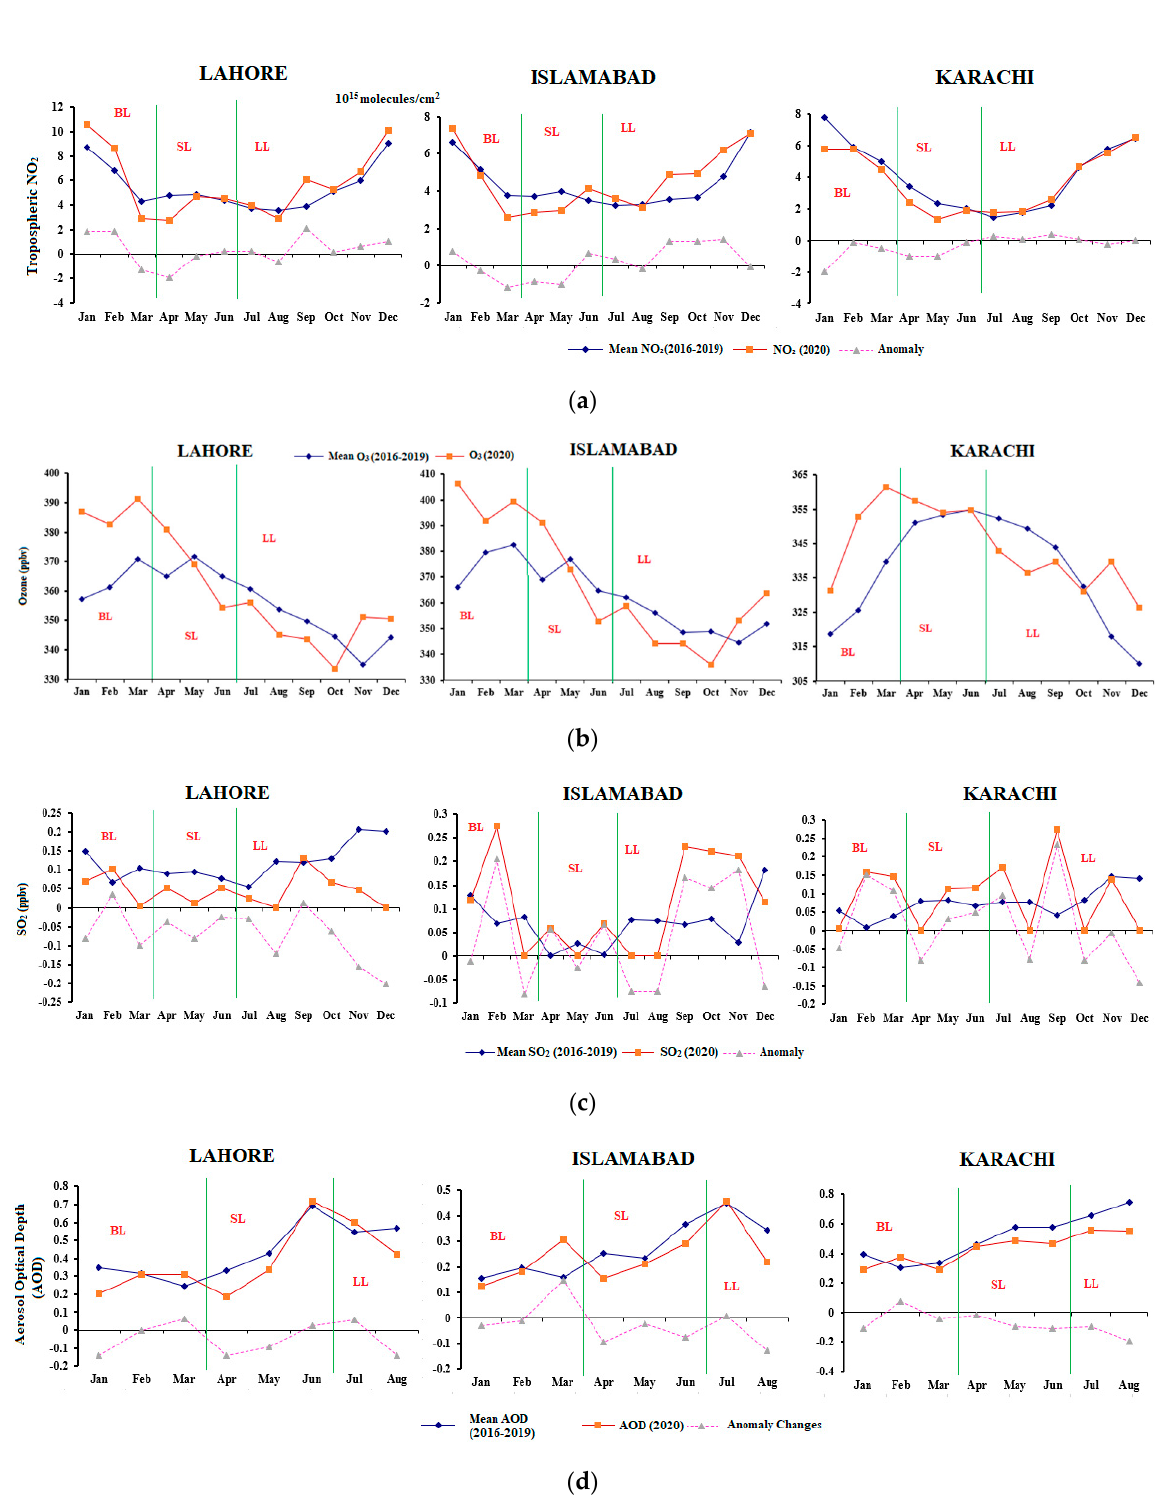
Figure 4. ( a ) Tropospheric NO 2 situation along with the lockdown scenarios in three metropolitan cities of Pakistan during the period Jan 2019–Dec 2020. ( b ) Total column ozone concentration along with the lockdown scenarios in three metro-